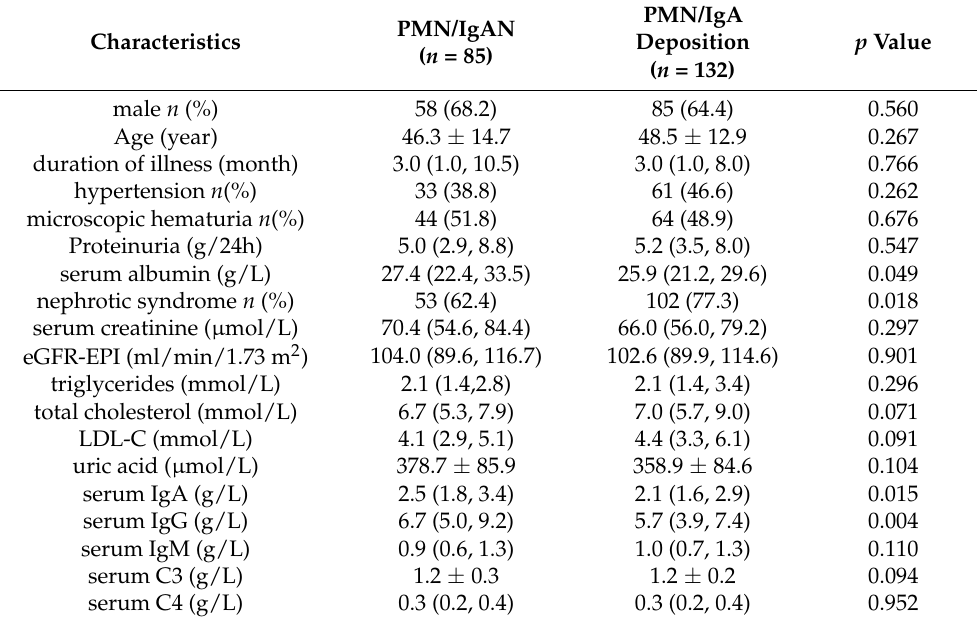
Table 1. Demographics and clinical features of patients with PMN/IgAN and PMN/IgA